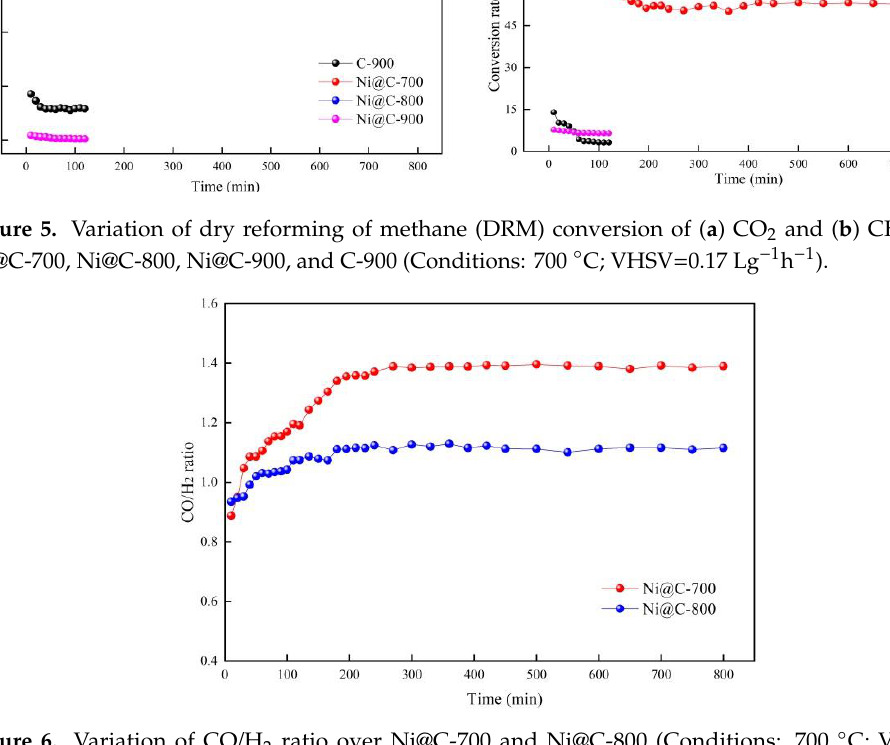
Figure 6. Variation of CO / H 2 ratio over Ni@C-700 and Ni@C-800 (Conditions: 700 ◦ C; VHSV = 0.17 Lg − 1 h − 1 ).